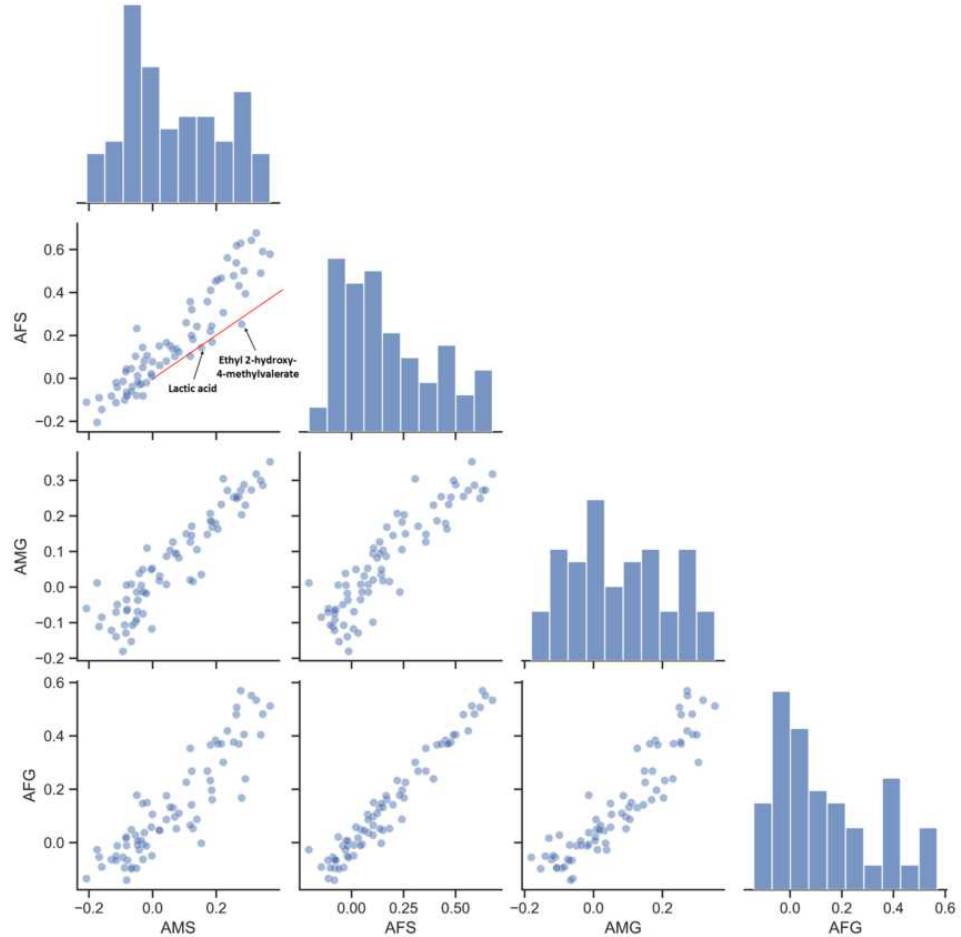
Figure 6. Comparison of explained variance of metabolites for aging-related models. Dot plots of the explained variance of the metabolite groups from models based on every pair of age-related models. Panels on the diagonal showed the marginal distribution of explained variance of metabolite groups for a certain age-related group. Aging-related factors 1 (AFS): aging year and microbial data annotated into species; aging microbiome 1 (AMS): microbial data annotated into species; aging-related factors 2 (AFG): aging year and microbial data annotated into genera; and aging microbiome 2 (AMG): microbial data annotated into genera.